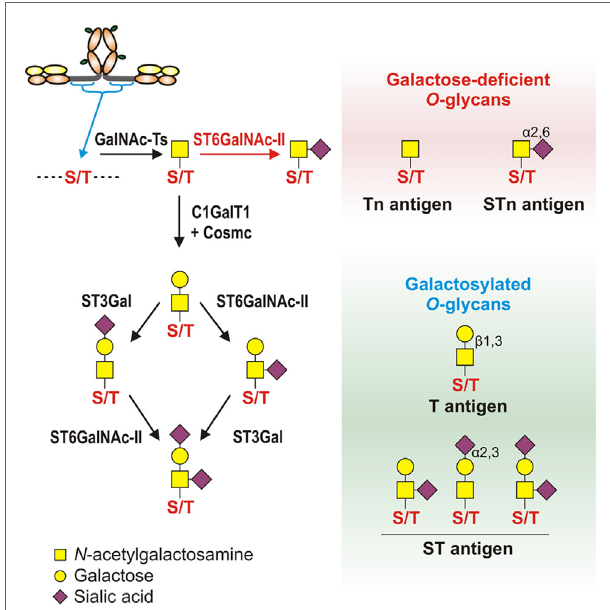
FiGURe 3 | Pathways of O -glycosylation of igA1 hinge region, including galactose-deficient and galactosylated O -glycans . Left panel : O -glycosylation of IgA1 hinge region occurs in the Golgi apparatus and begins with attachment of N -acetylgalactosamine (GalNAc) to Ser or Thr by an enzyme of UDP-GalNAc:polypeptide GalNAc-transferases family (GalNAc-Ts). In patients with IgAN, some terminal GalNAc residues may be prematurely sialylated by GalNAc α 2,6-sialyltransferase (ST6GalNAc) (red arrow); this step prevents addition of galactose (the glycan thus remains galactose-deficient). In healthy individuals, GalNAc- α -Ser/Thr residue can be normally modified by addition of galactose, catalyzed by UDP-galactose: GalNAc- α -Ser/Thr β 1,3-galactosyltransferase (C1GalT1); stability of C1GalT1 requires molecular chaperone Cosmc. Gal β 1,3-GalNAc structures may be further modified by addition of sialic acid to galactose residues through the activity of Gal β 1,3-GalNAc α 2,3-sialyltransferase (ST3Gal) and/or to GalNAc residues through the activity of ST6GalNAc. Right panel : galactose-deficient O -glycans consist of terminal GalNAc, also known as Tn antigen, or GalNAc with α 2,6-linked sialic acid, also known as STn antigen. Galactosylated O -glycans are disaccharides consisting of galactose and GalNAc (Gal β 1,3- GalNAc α 1-O-Ser/Thr, also known as T antigen) and may be modified by sialic acid (also known as ST antigen). T antigen does not carry sialic acid, but ST antigen has sialic acid attached to galactose and/or